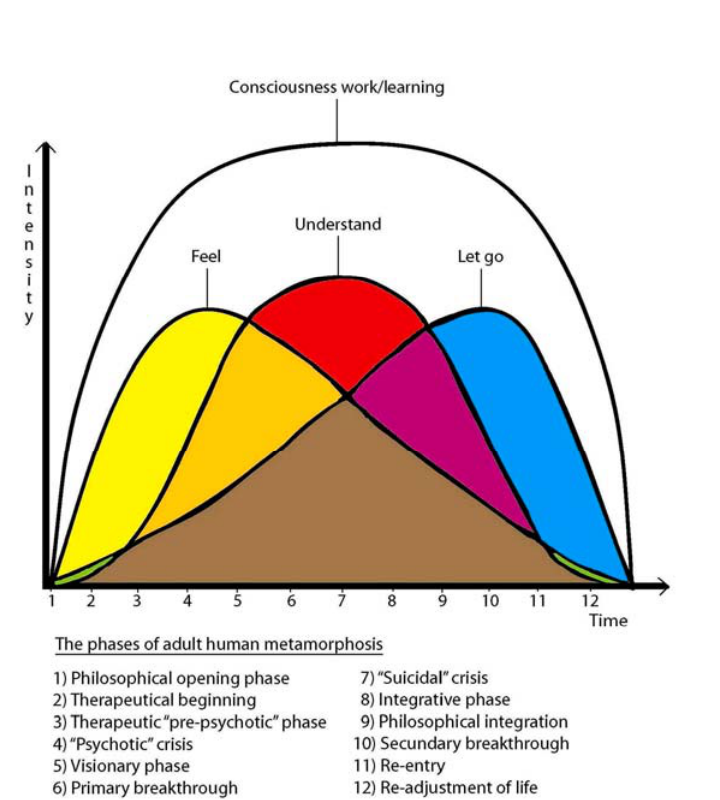
Figure 1. The process of holistic healing seen as three phases of feeling (yellow), understanding (red), and letting go (blue) of negative beliefs, attitudes, and decisions. As an end result, the process was improving the patient’s philosophy of life and thus allowed the patient to rebalance existence and to assume responsibility for life. During the process, the patient’s will re-established quality of life, health, and existential coherence, along with the ability to love, understand, and enjoy the whole spectrum of feelings and emotions, including